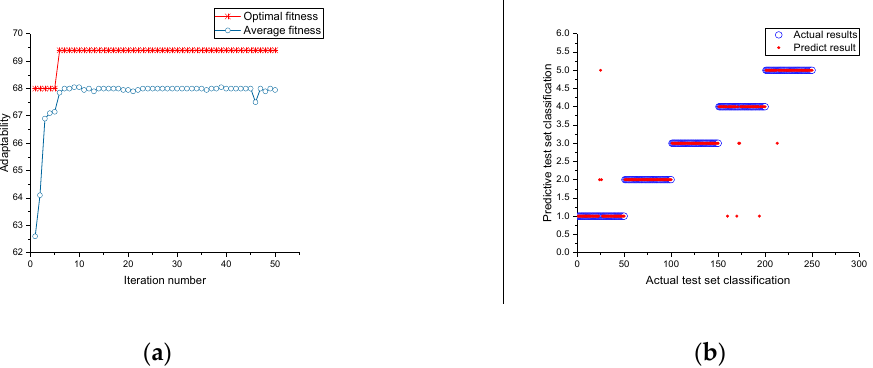
Figure 12. PNN iterative process and results after PSO optimization. ( a ) Iterative optimization process, ( b ) Final classification results.